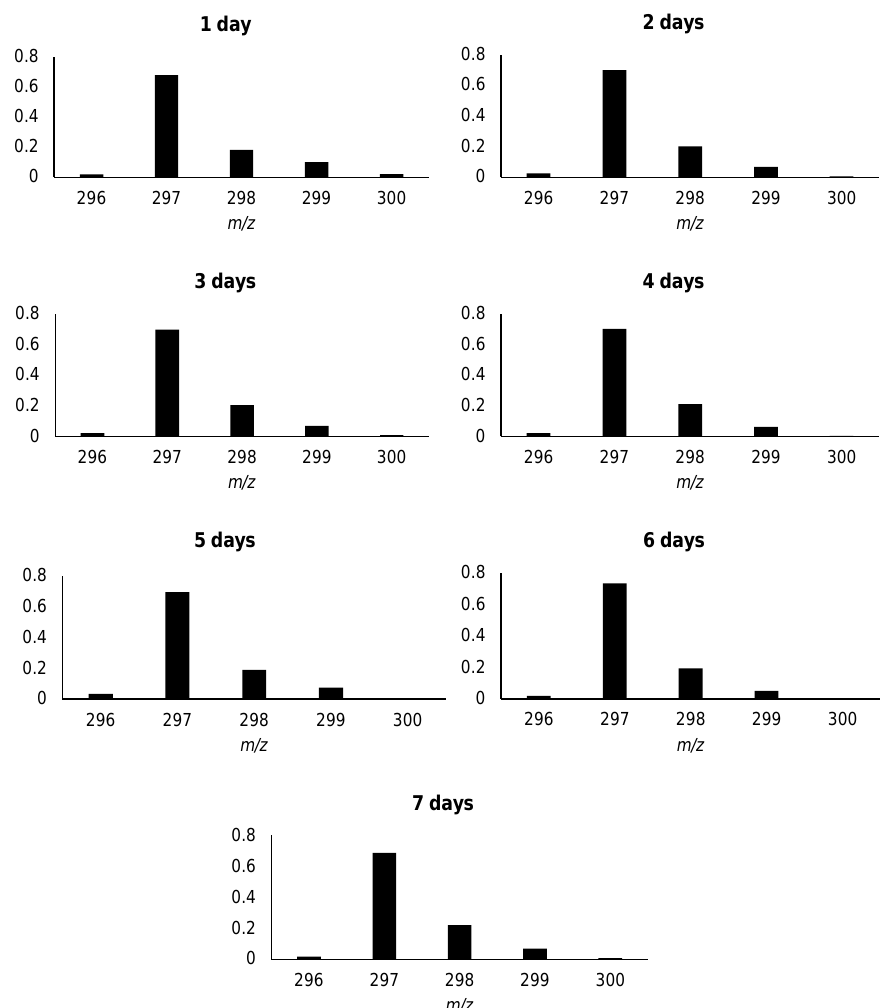
Figure 9. Kinetics of DHX reaction of armodafinil-d 3 in 1% TEA/H 2 O/MeCN/solutions. To determine the location of the remained deuterium atom after the DHX, the MS/MS experiments were performed, and the obtained spectra are presented in the Figure 10. The ESI-MS spectrum of armodafinil-d 1 obtained after the analysis of DHX presents intensive signal at m / z 168.087 corresponding to the secondary carbocation containing deuterium atom (Figure 10A). The MS/MS spectrum obtained for parent ion at m / z 297.075 shows the signal corresponding to the aliphatic radical coordinating sodium ion at m / z 128.983 without any deuterium atom (Figure 10B). The obtained results clearly indicate that the unexchanged deuterium atom remained at the carbon atom within the diphenylmethyl group.